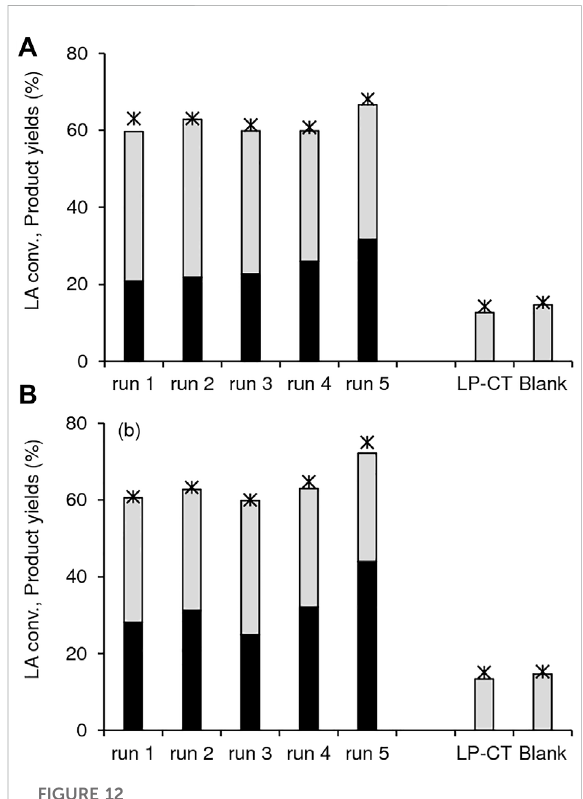
FIGURE 12 Conversion of LA (*) and yields of GVL (black bars) and 2BL (greybars)inthepresenceof (A) 1.40Hf-D-HL(0.15)and (B) 1.12Hf- D-HL(0.28). The contact tests (LP-CT) for each catalyst as well as the blank test (without catalyst at 5 h) are included for comparison. Reaction conditions: 0.45 M LA in 2BuOH, 25.5 g cat L − 1 , 200 ° C, 5